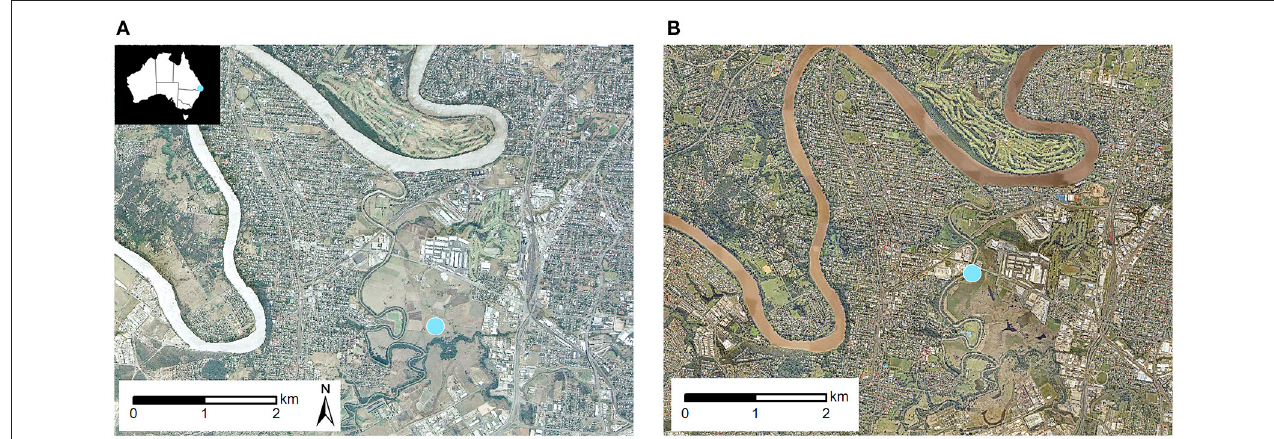
FIGURE 1 | Aerial photographs of Rocklea (A) on 4th of October 1994 (QImagery, The State of Queensland 2021) and (B) on 11th of April 2017 (Nearmap). Rocklea pollen monitoring site indicated with a Blue marker.